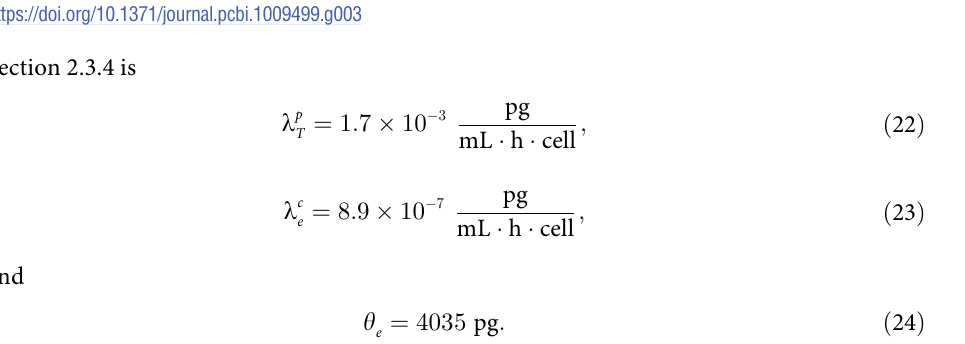
fluorescence shown in red). Fig 3B and 3C show the observed number of TIME and IBC3 cells over time with the calibrated logistic growth model for TIME cells and exponential growth for IBC3 cells. Fig 3D shows the posterior distribution function of parameters inferred using the IncuCyte and ELISA data. The calibrated parameters from Fig 3B and 3C are utilized in the models of VEGF secretion and consumption by IBC3 and TIME cells, respectively, to calibrate VEGF production, consumption, and carrying capacity. These posterior distributions are sampled to propagate uncertainty in the ODE models of VEGF secretion and consumption, with the one standard deviation confidence intervals shown in Fig 3E. The VEGF concentration models for tumor and endothelial cell have an average relative error of 11% and 16.7%, respectively. The calibrated parameter distributions for VEGF production and consumption are integrated back into the hybrid multiscale angiogenesis model for subsequent